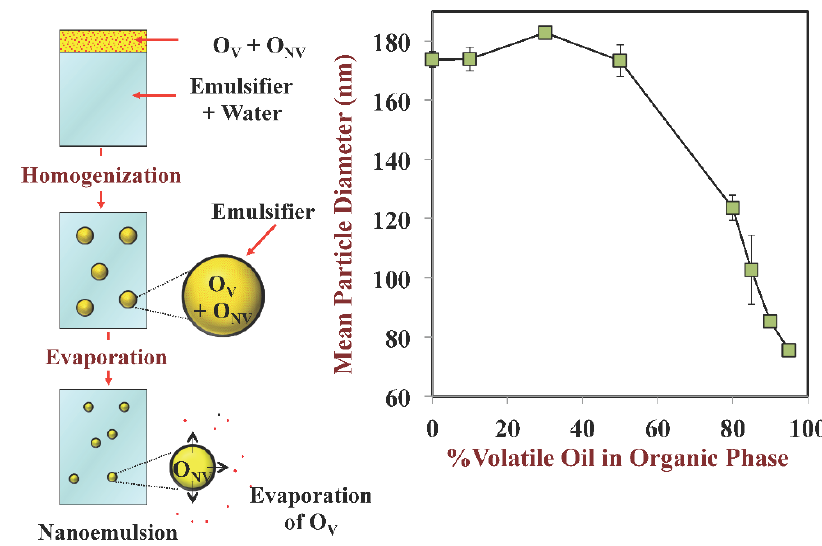
Figure 2. The droplets in an oil-in-water emulsion may be reduced in size after homogenization by evaporation methods. A volatile oil ( O V ) and non-volatile oil ( O NV ) are homogenized to form an emulsion, and then the volatile oil is removed by evaporation [38].